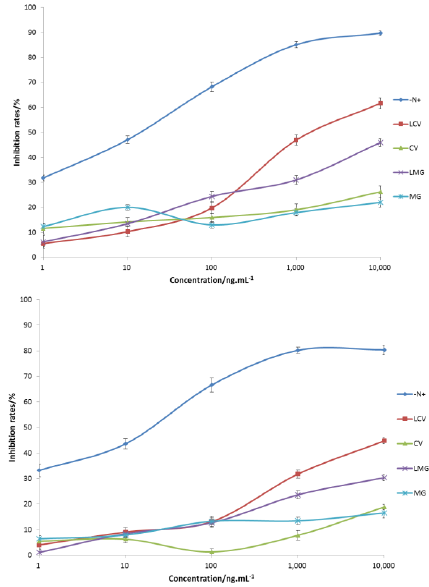
Figure 4. Ci-ELISA curves for rabbit ( top ) and mice antibodies ( bottom ). Repeated three times.